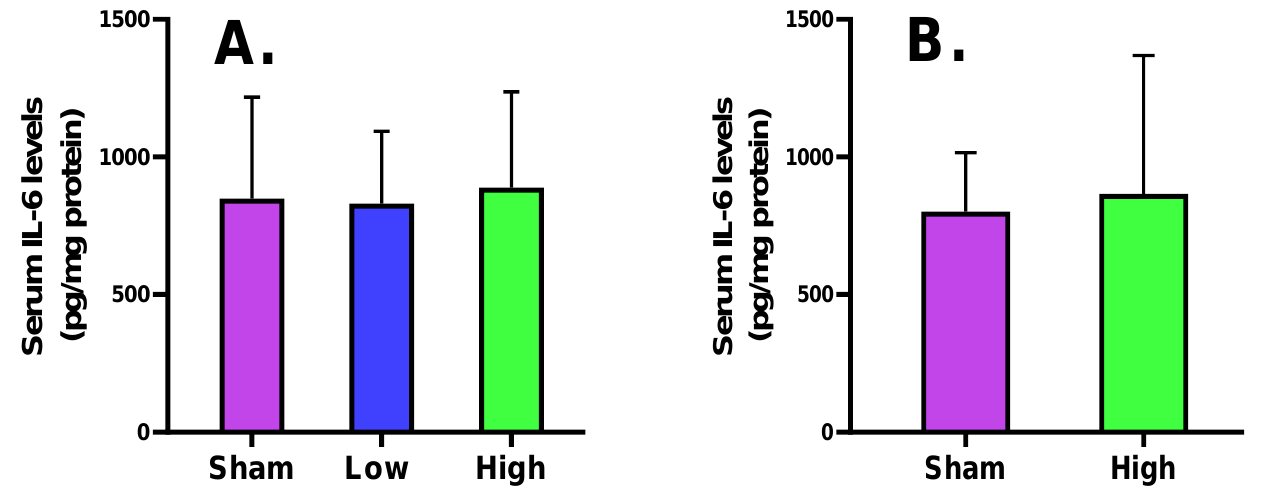
Figure 6. Effect of tDCS-iTBS on serum IL-6 levels (pg/mg protein): ( A ) short-term ( n = 15) and ( B ) long-term stimulations ( n = 16).